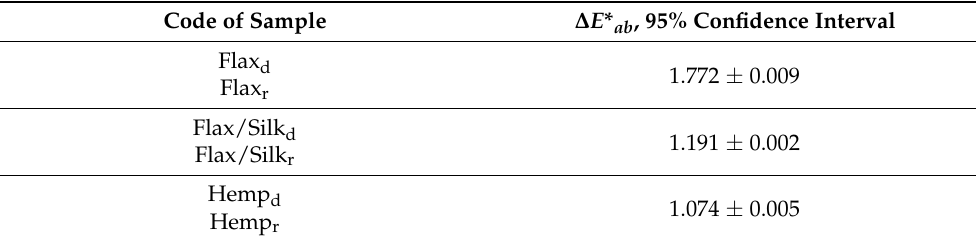
Table 1. Colour difference between dense and sparse parts of dyed woven